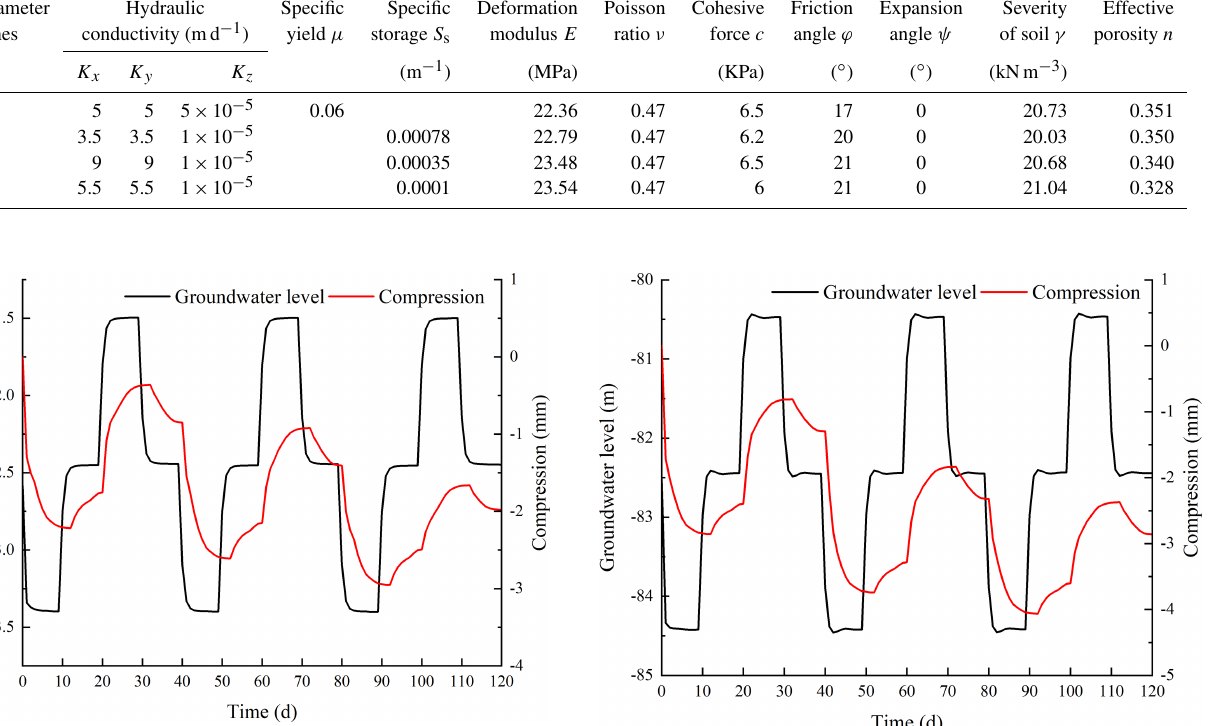
Figure 3. Compressed volume and water level with stress period in the fourth confined aquifer group under the first pumping and recharge scheme